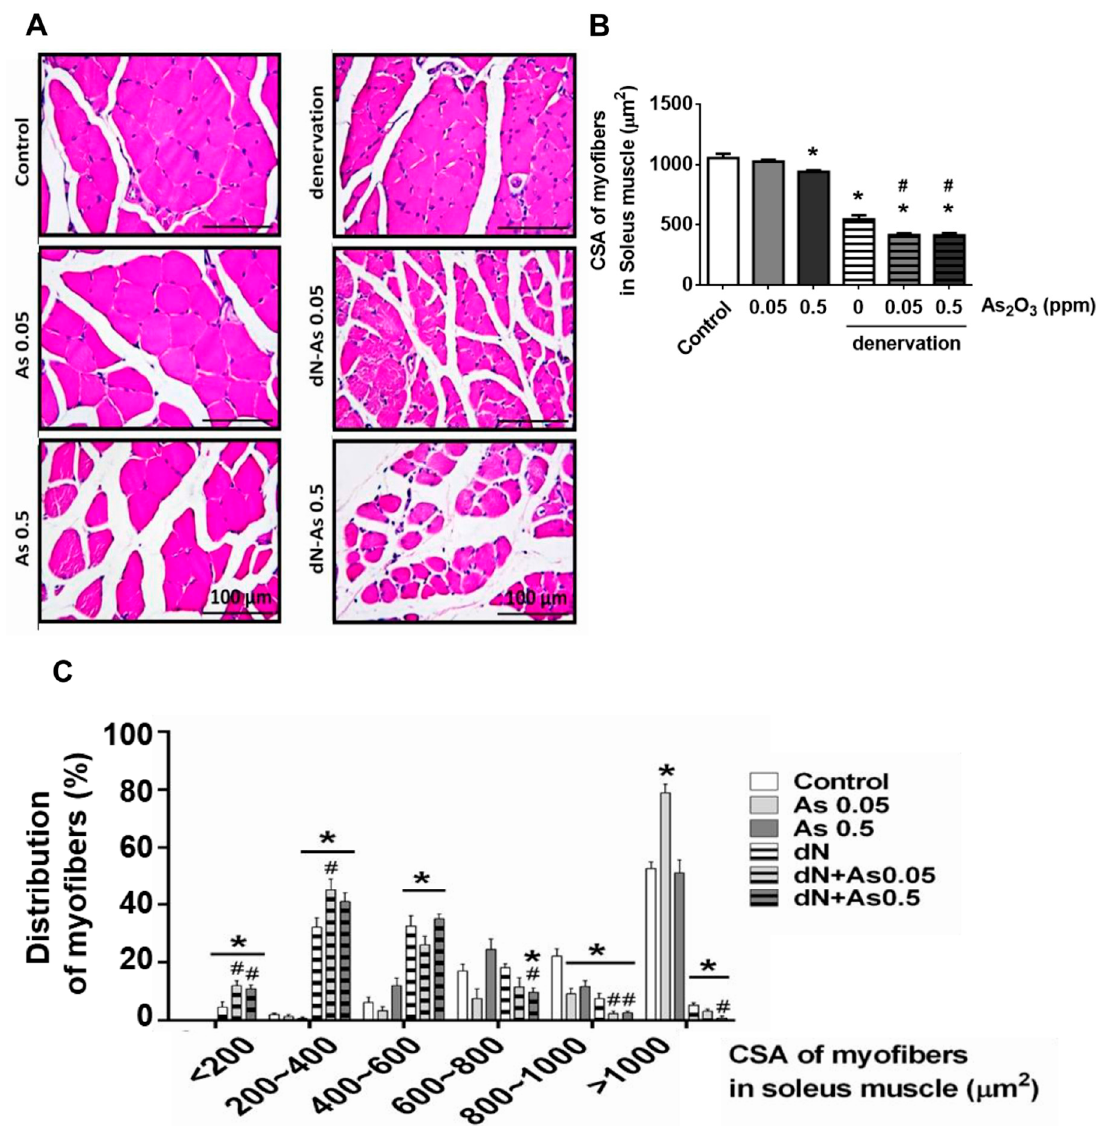
Figure 4. Effects of As 2 O 3 on muscle fiber cross-sectional area (CSA) in mice with or without denervation. As 2 O 3 (0.05 and 0.5 ppm) exposure from drinking water for 4 weeks in normal mice or denervated mice. The representative hematoxylin and eosin -stained muscle sections ( A ), the average cross-sectional areas (CSA) of myofibers ( B ), and the frequency distribution of myofibers ( C ) in soleus muscles were shown. Scale bar = 100 μ m. Data are presented as the mean ± SEM ( n = 6 of each group). * P < 0.05 compared to the control group; # P < 0.05 compared to the denervation group.